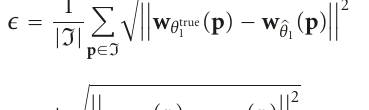
Table 1: Optimal filter weights for the five possible configurations. The noise standard deviation noise of the acquired image is denoted σ , the one of the previous denoised image σ (cid:12)